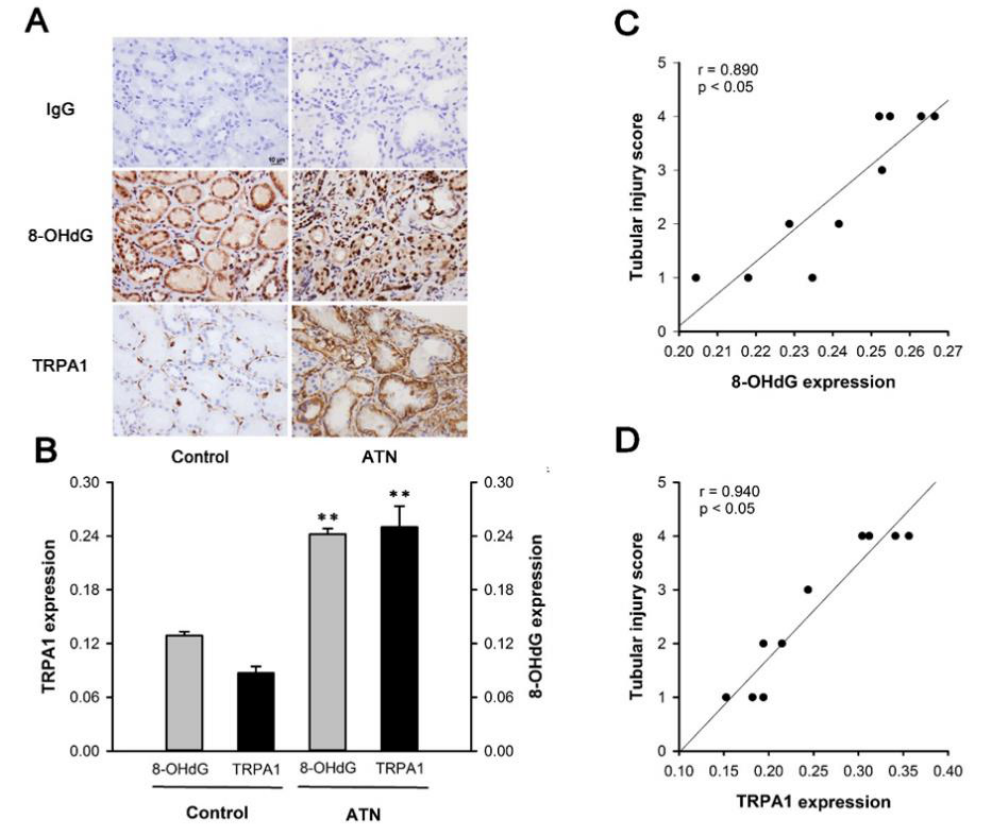
Figure 1. Patients with acute tubular necrosis (ATN) and acute renal injury display increased expres- sion of renal tubular transient receptor potential ankyrin 1 (TRPA1) and 8-hydroxy-2 (cid:48) -deoxyguanosine (8-OHdG), a biomarker of oxidative stress. ( A ) Representative images showing immunostaining with an antibody against TRPA1 or 8-OHdG. Renal sections were obtained from normal control subjects and patients with ATN. The specificity of the immunostaining was confirmed by using an IgG-negative control. The magnification of each panel was 400 × . ( B ) Quantification of the expression levels of renal tubular TRPA1 and 8-OHdG in the renal sections with immunostaining. Data in each group are the mean ± SEM from 10 patients. ** p < 0.01 versus the control group. ( C , D ) Pearson correlation analyses of expression of renal tubular TRPA1 or 8-OHdG with tubular injury score in patients with ATN ( n = 10); r represents the correlation coefficient. Tubular injury score was calculated according to the percentage of injured area of tubular cross sections. The scoring system is described in the Methods section.